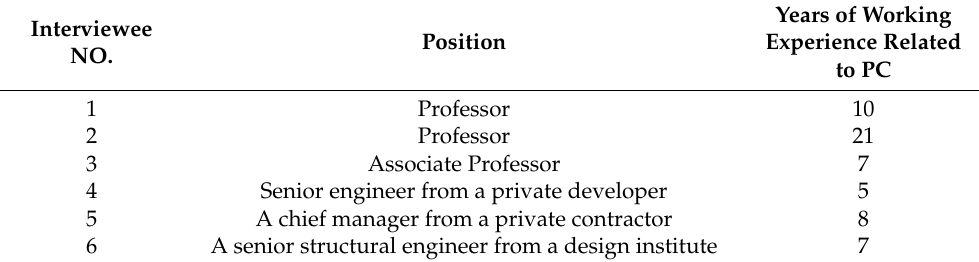
Table 4. Profile of the experts invited to weight the indicators.